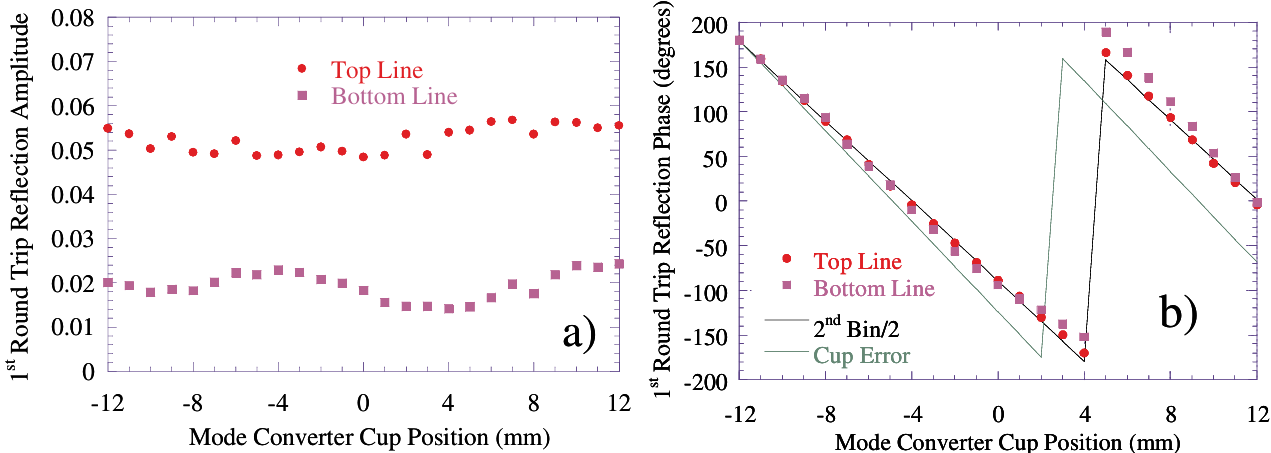
FIG. 18. (Color) Variations in (a) amplitude and (b) phase of spurious reflection (initial reflection after one round-trip) as a function of the end mode converter